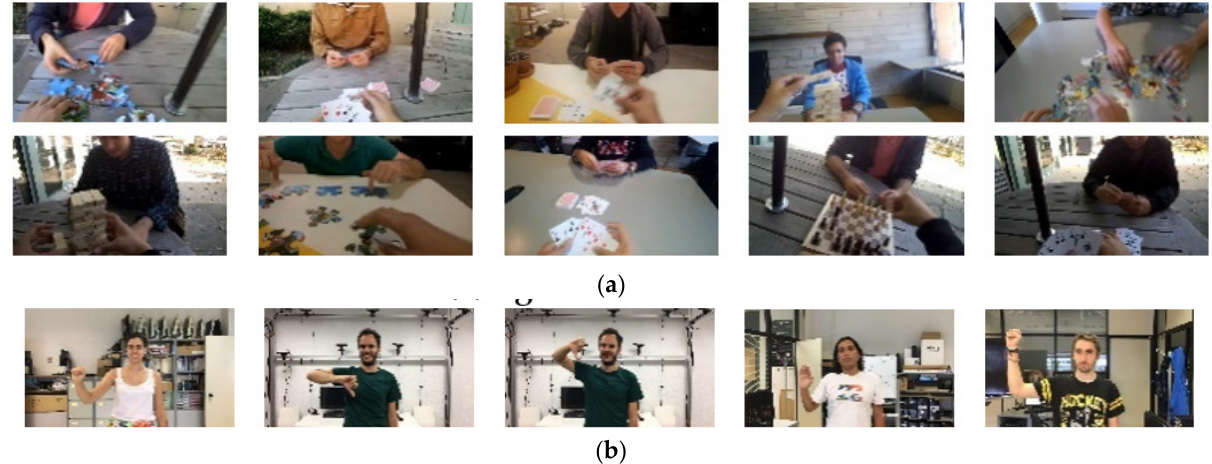
Figure 4. Datasets; ( a ) EgoHands dataset; ( b ) TinyHGR dataset